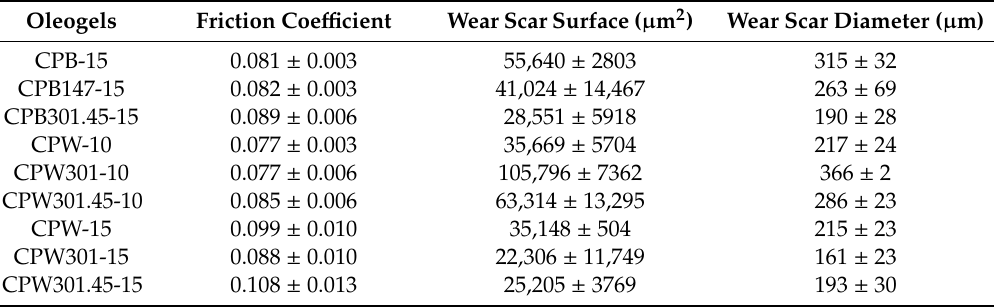
Table 4. Values of the friction coe ffi cient and sizes of wear